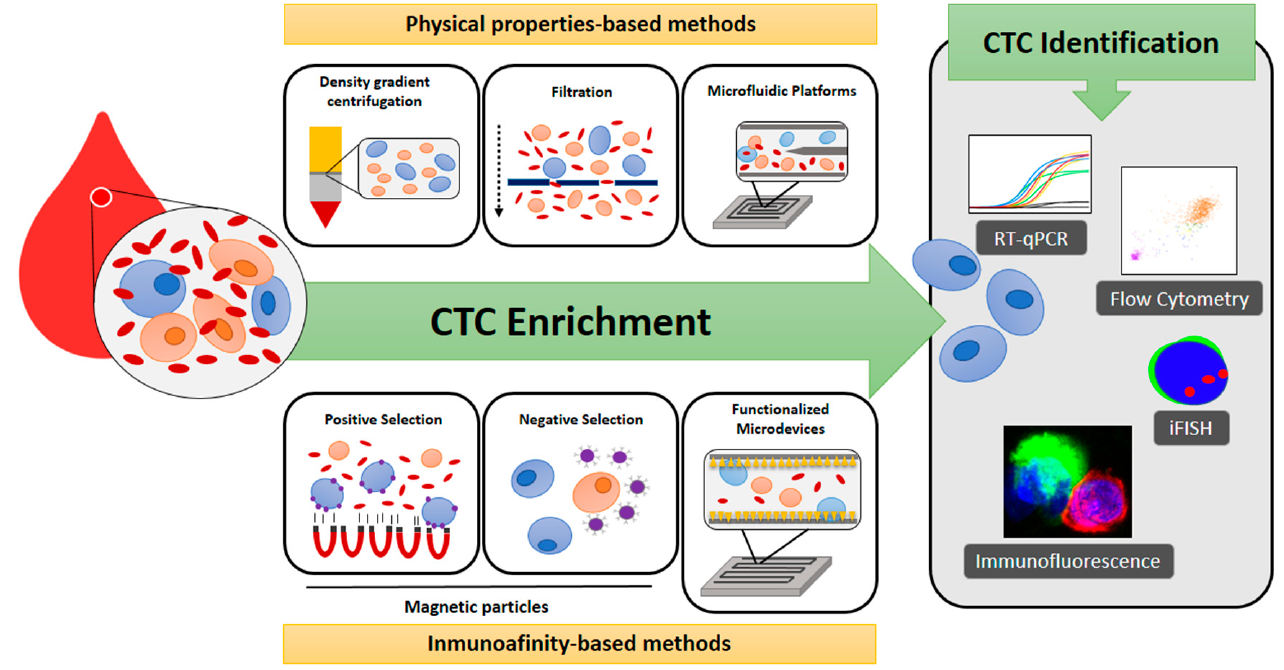
Figure 1. Illustration summarizing the most relevant methodologies for circulating tumor cells (CTCs) enrichment and detection.